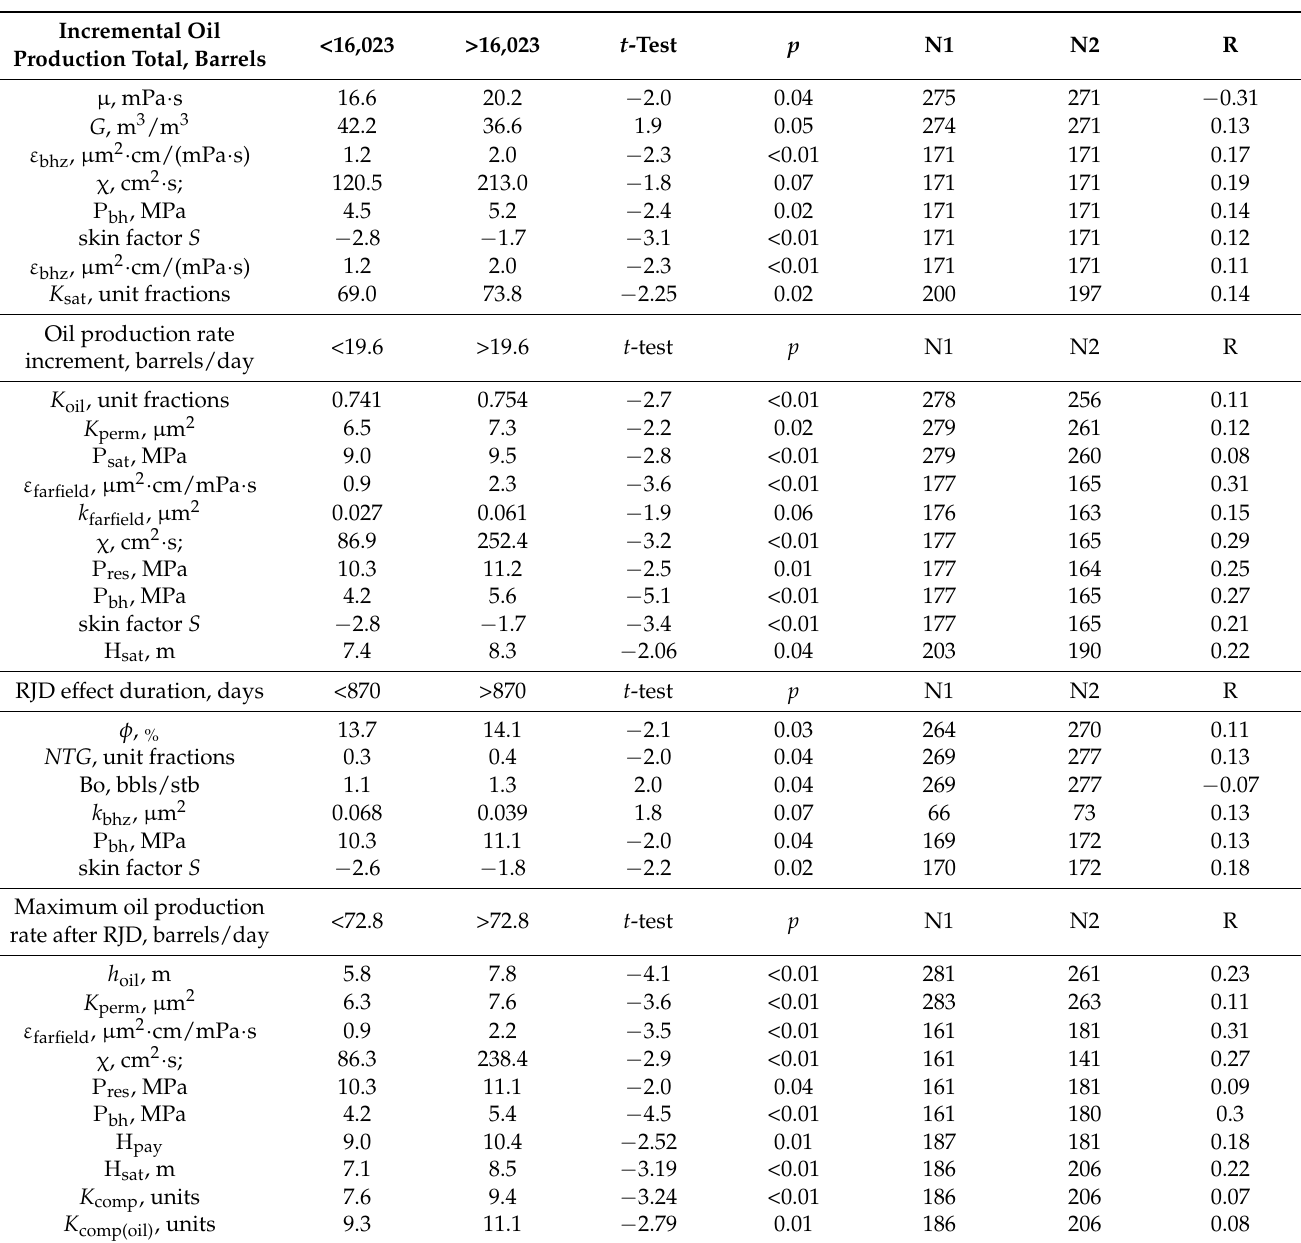
Table 2. Result of t -test